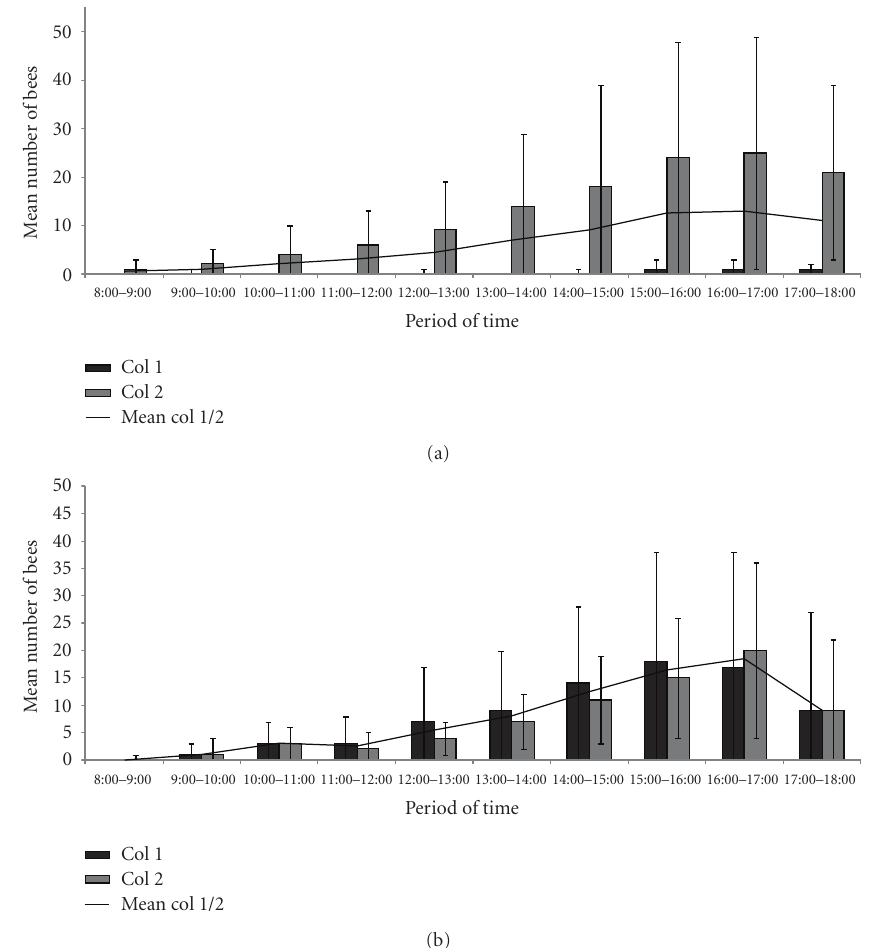
Figure 6: Garbage removal patterns of two colonies of Plebeia remota in the reproductive phase (a) and in the diapause